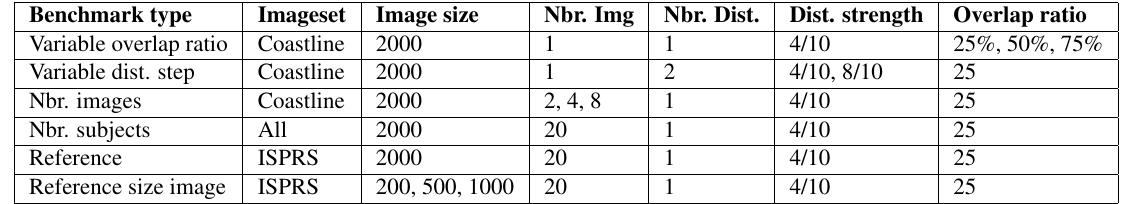
Table 1. Test cases